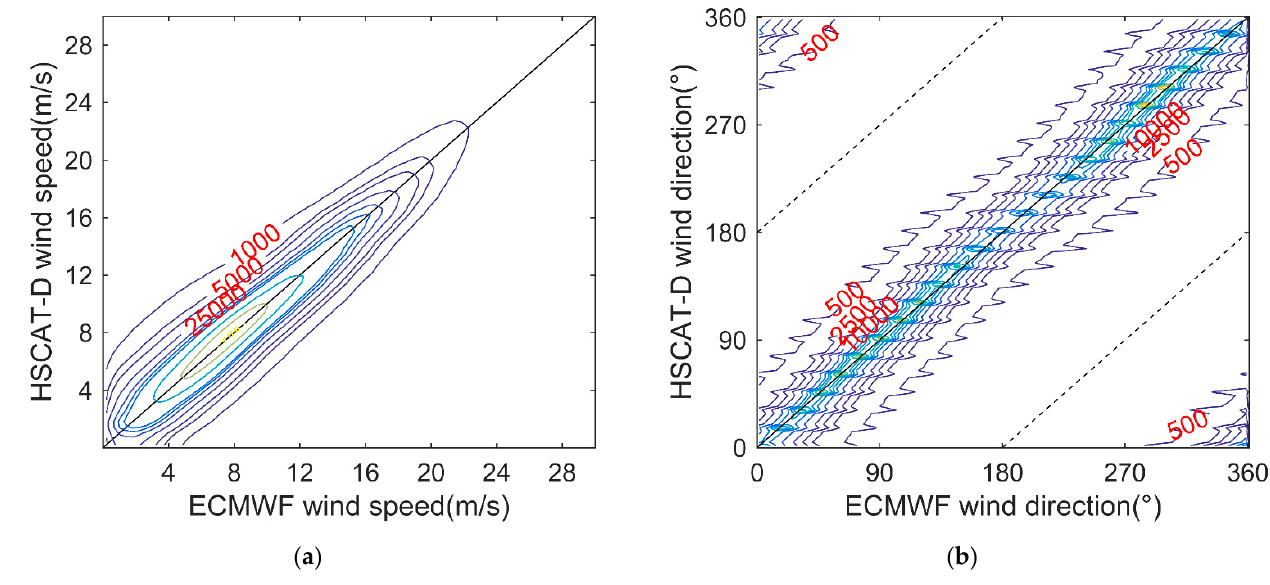
Figure 5. Scatterplots of wind speed ( a ) and direction ( b ) derived from HSCAT-D versus ECMWF winds.